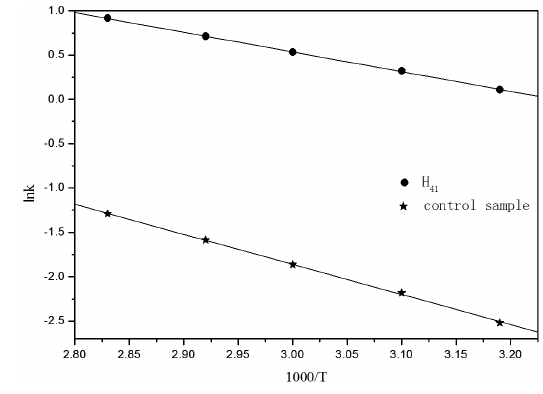
Figure 6. Conversion-time curves of the control sample at different temperatures.